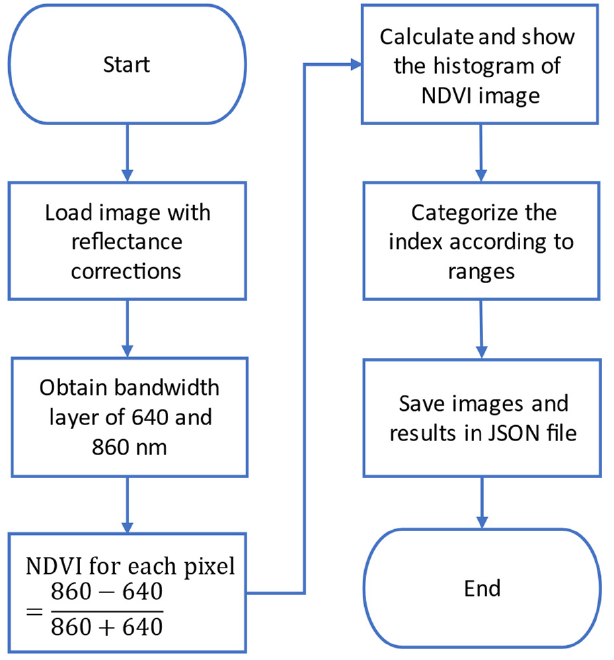
Figure 12. Flowchart of the main steps in the NDVI index processing.